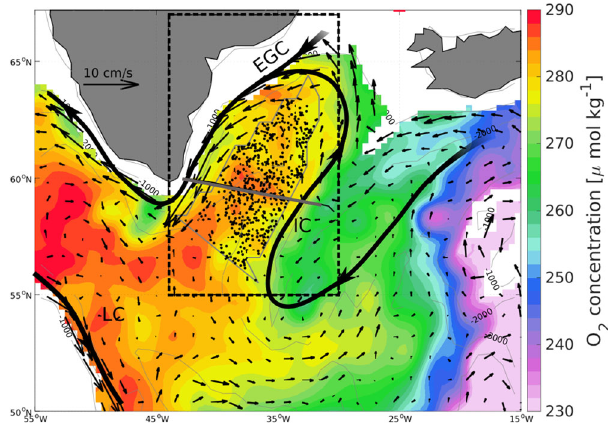
Fig. 1 Oxygen concentration and main circulation in the North Atlantic Ocean. Mean oxygen concentration averaged between 900 and 1100 m depth as computed from ISAS (color-coded). The location of the Argo pro fi les used in this study is represented by black dots within the bathymetric contour of 2700 m that we used to de fi ne the core of the Irminger Sea (gray contour). The gray line shows the average location of the hydrographic sections (OVIDE, AR07E, A01E). The black, thick curve represents the surface current, and the main currents in the region, i.e. the Eastern Greenland current (EGC), the Irminger Current (IC) and the Labrador Current (LC), and it is superimposed to the mean circulation at 1000 m (computed from ANDRO). The dashed rectangle represents the region where we average the Wind Stress Curl (WSC), the relative vorticity on the ocean circulation at 1000 m and the detrended annual-mean Sea Level Anomaly (SLA) (Fig.